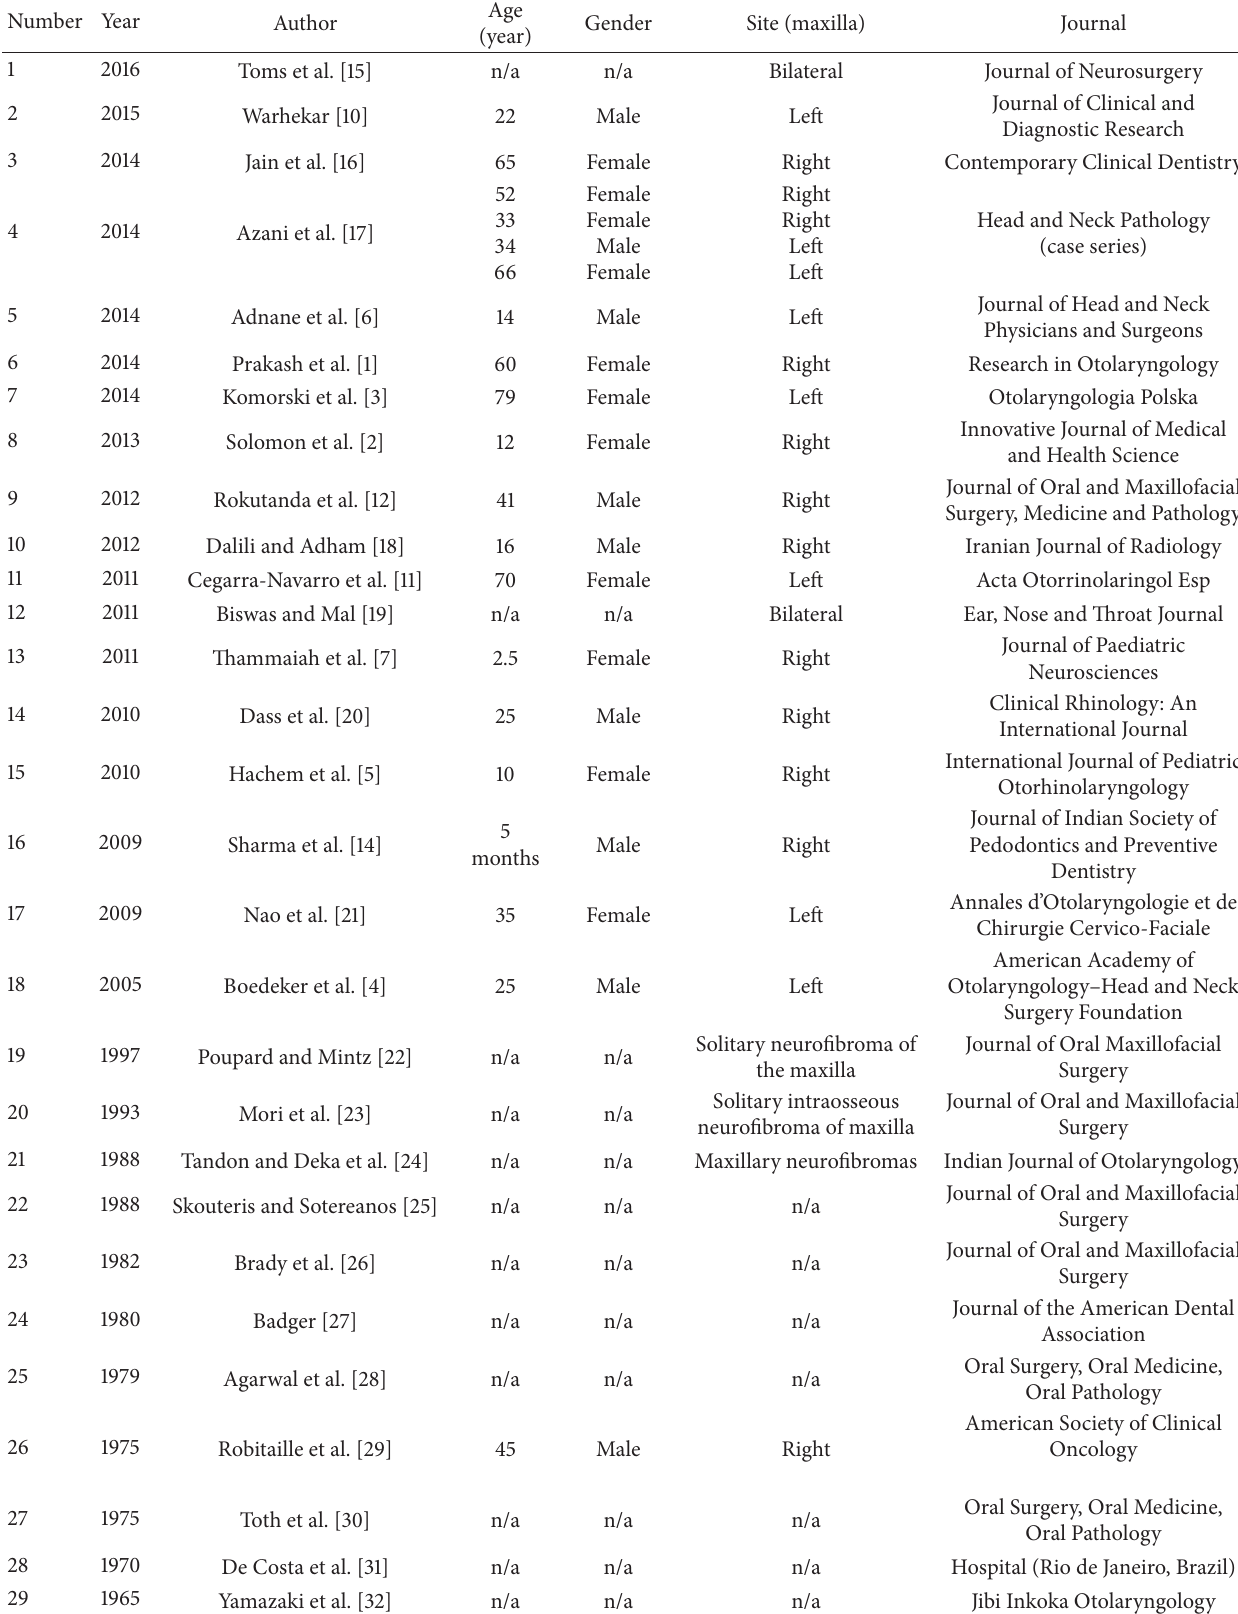
Table 1: Case reports on maxillary